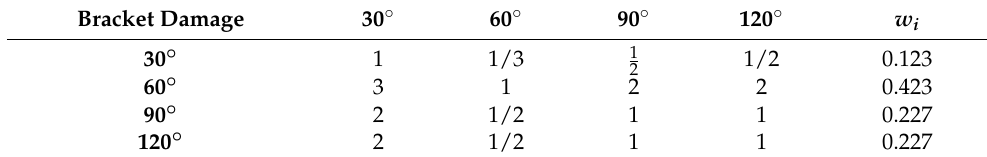
Table 17. Important degree judgment matrix for bracket damage at different wind attack angles. Bracket